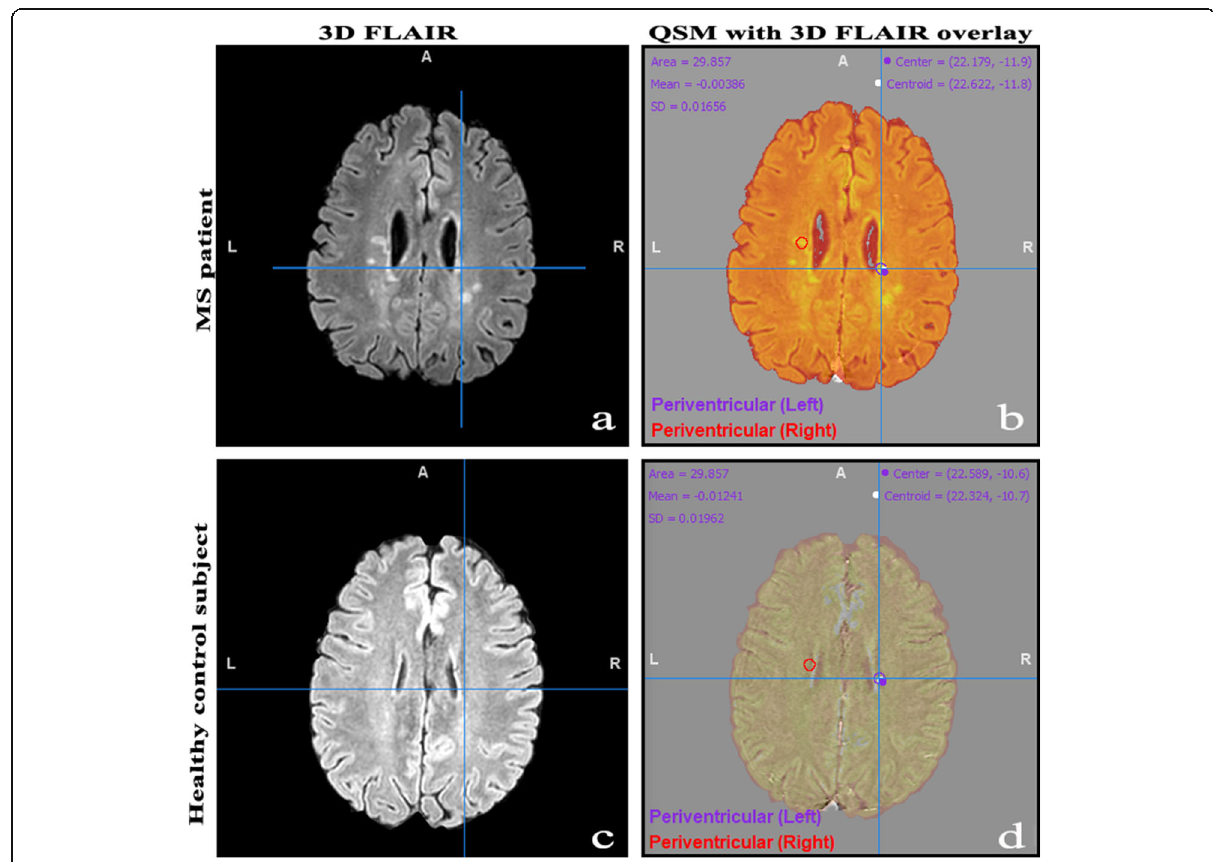
Fig. 4 Measuring regional iron load in a 39-year-old man with relapsing-remitting multiple sclerosis ( A , B ) in periventricular lesions and measuring iron load in corresponding locations in a healthy 44-year-old male control subject. A represents an axial three-dimensional fluid- attenuation inversion recovery (3D FLAIR) film of the patient demonstrating two periventricular lesions (right and left). The 3D FLAIR film was overlayed on the quantitative susceptibility map as depicted in image B and the transparency was set to 50% to visualise both the quantitative susceptibility mapping (QSM) and the 3D FLAIR images. Two regions of interest (ROIs), shown as red and violet circles, were placed in the periventricular lesions and the ROIs were analysed on the QSM image. C Represents a corresponding axial 3D FLAIR cut of a healthy man. Similar steps were performed to measure iron in approximate locations corresponding to the MS periventricular